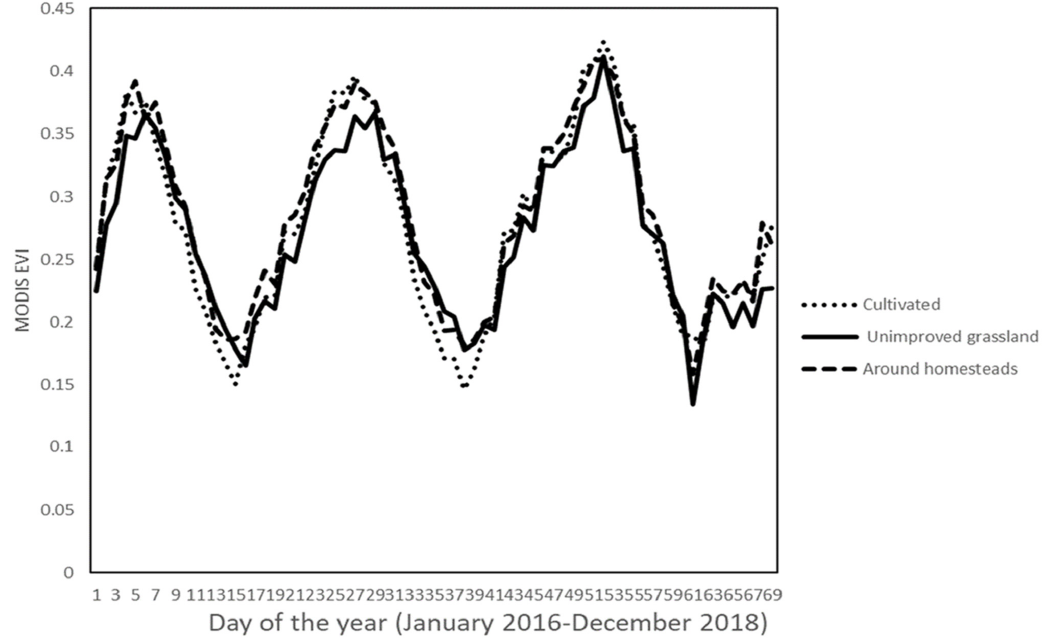
Figure 10. MODIS EVI for three grazing domains in the village of Mgwalana for the period of